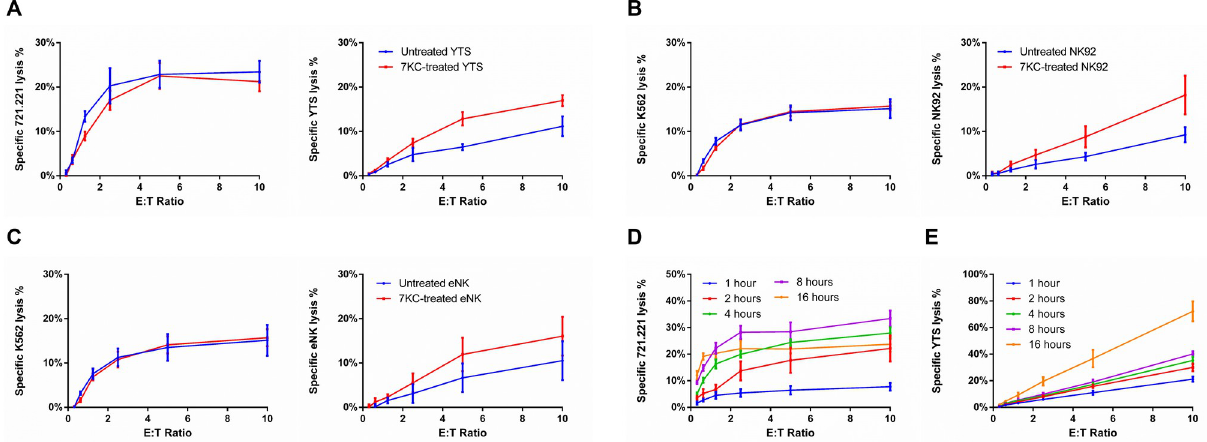
Fig 2. 7KC treatment of NK cells induces NK cell death during target killing. Cytotoxic function (A, left, ns) and survival (A, right, p < 0.05) of untreated or 7KC-pretreated YTS cells incubated with 721.221 target cells were measured using 4-h 51 Cr release assay. Similarly, cytotoxic function (B, left, ns) and survival (B, right, p < 0.05) of untreated or 7KC-pretreated NK92 cells incubated with K562 cells were measured by 4-h 51 Cr release assay. To measure cytotoxic function in each case, target cells were 51 Cr labeled (A, B, left), whereas to measure survival of NK cells, the NK cells themselves were 51 Cr labeled (A, B, right), and for both, the 51 Cr release was measured after 4 h of incubation. To validate the elevated death of 7KC-pretreated YTS cells, the cytotoxic function (C, left, ns) and survival (C, right, p < 0.05) of primary human purified eNK cells were measured after their labeling with 51 Cr and when incubated with K562 cells with or without 7KC pretreatment. A correlation between NK cell survival and cytotoxicity after 7KC treatment was evaluated by varying the duration of incubation for assays measuring cytotoxicity (D) and survival (E) of 7KC-pretreated YTS cells incubated with 721.221 target cells using 51 Cr-labeled NK or target cells, respectively. All values presented represent averages of 3 independent experiments (NK cell lines) or 5 distinct healthy donors and error bars display ± SD (A − E). Wilcoxon signed rank test was used for the comparison between curves. eNK, ex vivo NK; NK, natural killer; ns, not significant; 7KC,